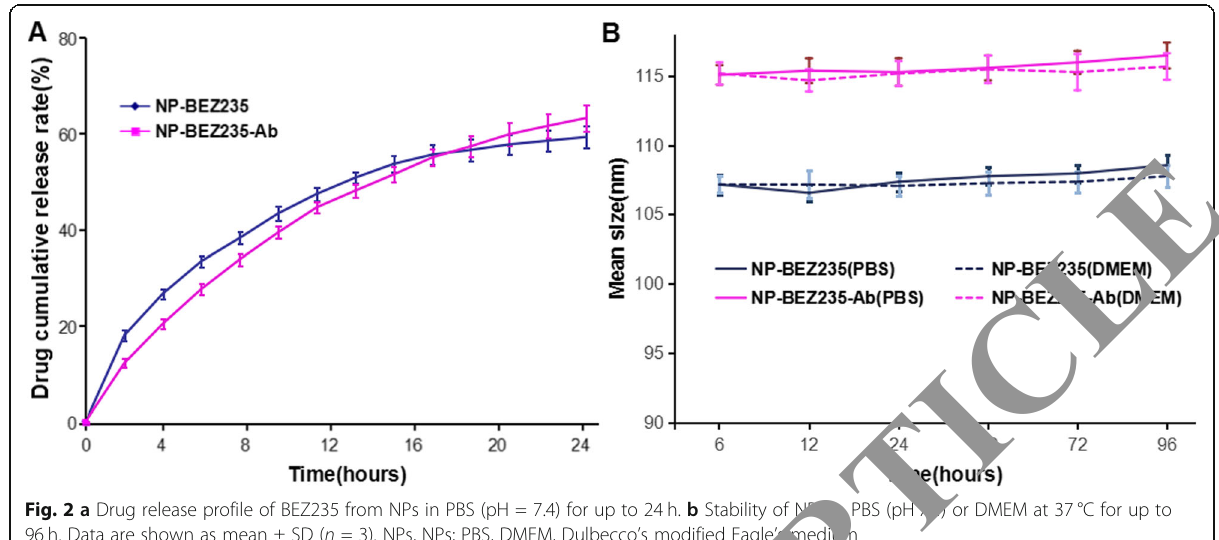
Fig. 2 a Drug release profile of BEZ235 from NPs in PBS (pH = 7.4) for up to 24 h. b Stability of NPs in PBS (pH 7.4) or DMEM at 37 °C for up to 96 h. Data are shown as mean ± SD ( n = 3). NPs, NPs; PBS, DMEM, Dulbecco ’ s modified Eagle ’ s